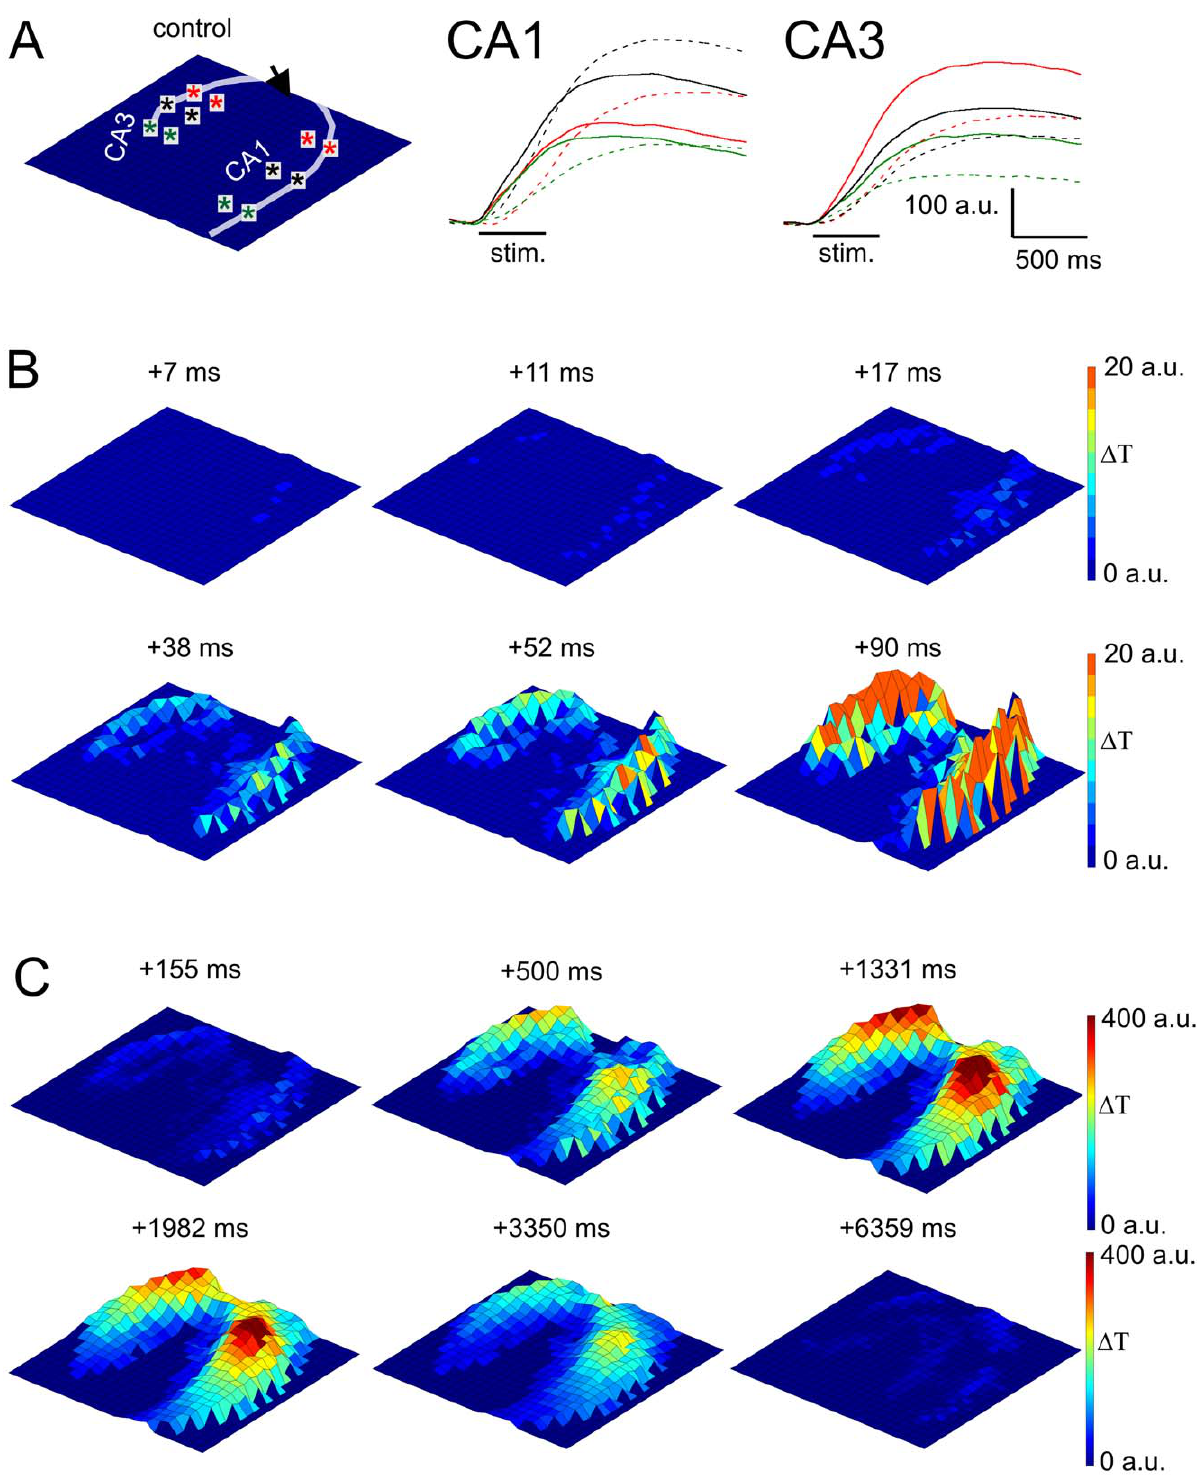
Figure 2. Temporal dissection of the IOS signal. A Left: Orientation of the slice. Transparent line indicates the pyramidal layer and the arrow indicates the position of the stimulating electrode. A Middle and Right: Representative IOS traces from the CA1 and CA3 region respectively. The origins of the traces are indicated by colored asterisks on A left. Dashed lines indicate IOS traces originating from the str. radiatum . B: 3D IOS amplitude maps at different time points showing the spatial appearance of IOS in the first 90 ms following stimulus onset. The orientation of the slice is represented on A left. C: 3D IOS amplitude maps at different time points showing the spatial dynamics of IOS at a longer time-scale. The orientation of the slice is represented on A left. The colorbar indicates the transmittance change compared to the resting light intensity.